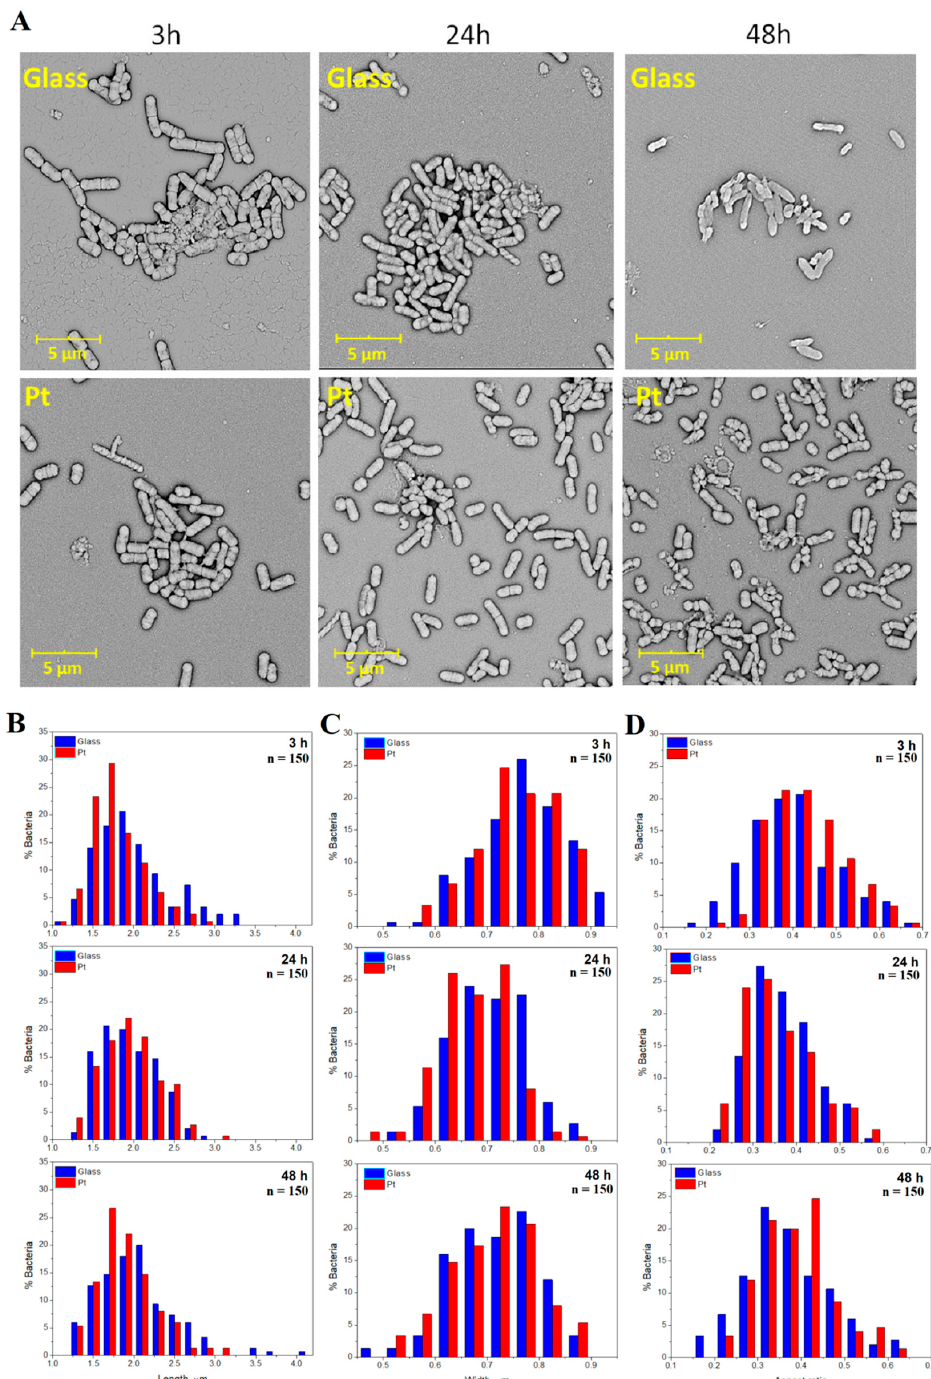
Figure 4. Size distribution of bacterial cells on bare and Pt-coated glass slides. ( A ) SEM micrographs presenting bacterial populations grown for 3 h, 24 h and 48 h on bare and Pt-coated glass; ( B ) histograms of the bacterial cells percentage in terms of specified values of ( C ) length, width and ( D ) aspect ratio, calculated from SEM images; n =